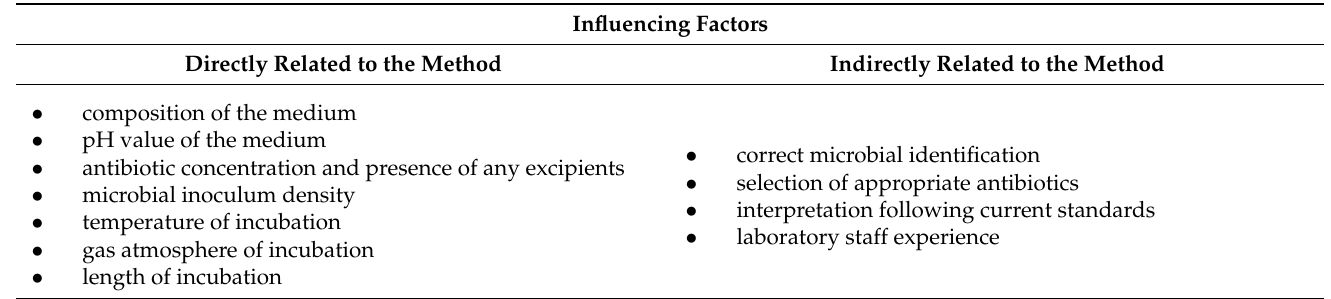
Table 1. Factors influencing antimicrobial susceptibility testing.